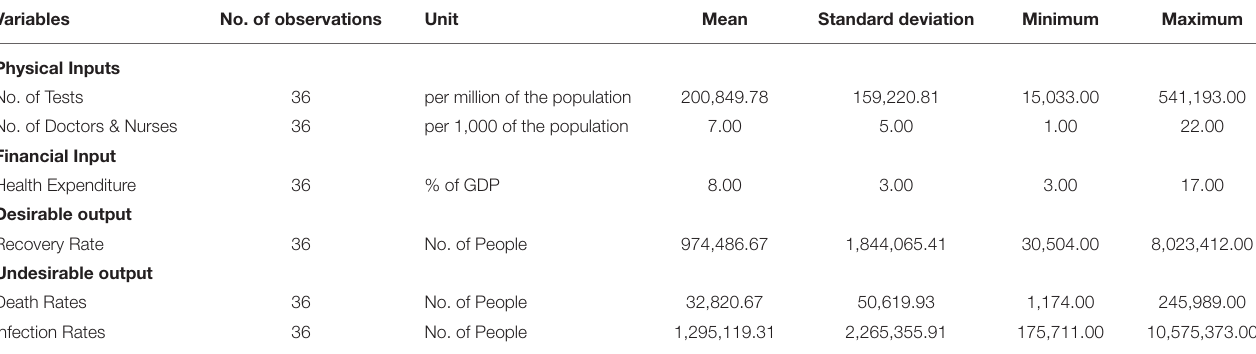
TABLE 1 | Descriptive statistics and variables used in the